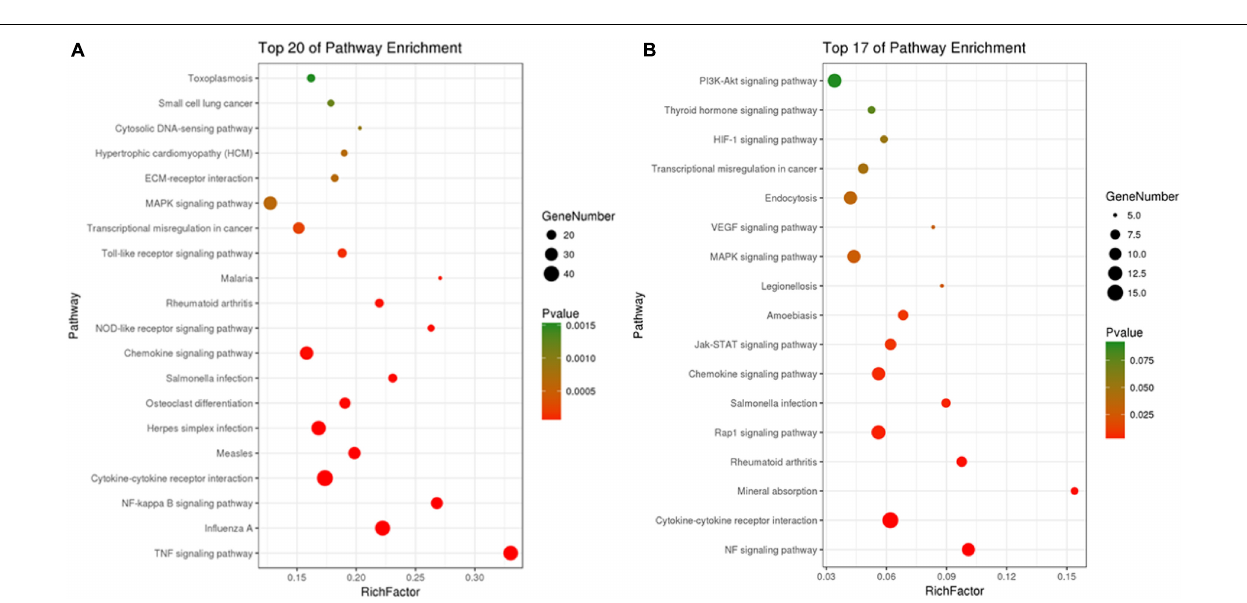
FIGURE 5 | Kyoto Encyclopedia of Genes and Genomes (KEGG) pathways annotation and classification of DEGs in C vs. LPS (A) and LPS vs. HOA (B) .